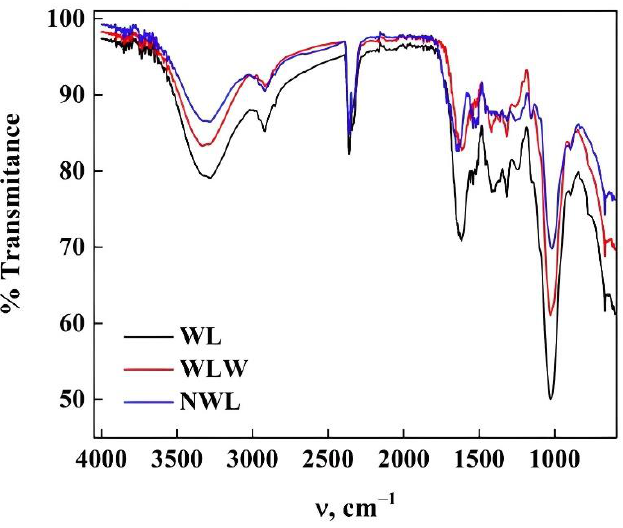
Figure 10. ATR-FTIR spectra of WL with the different treatments.